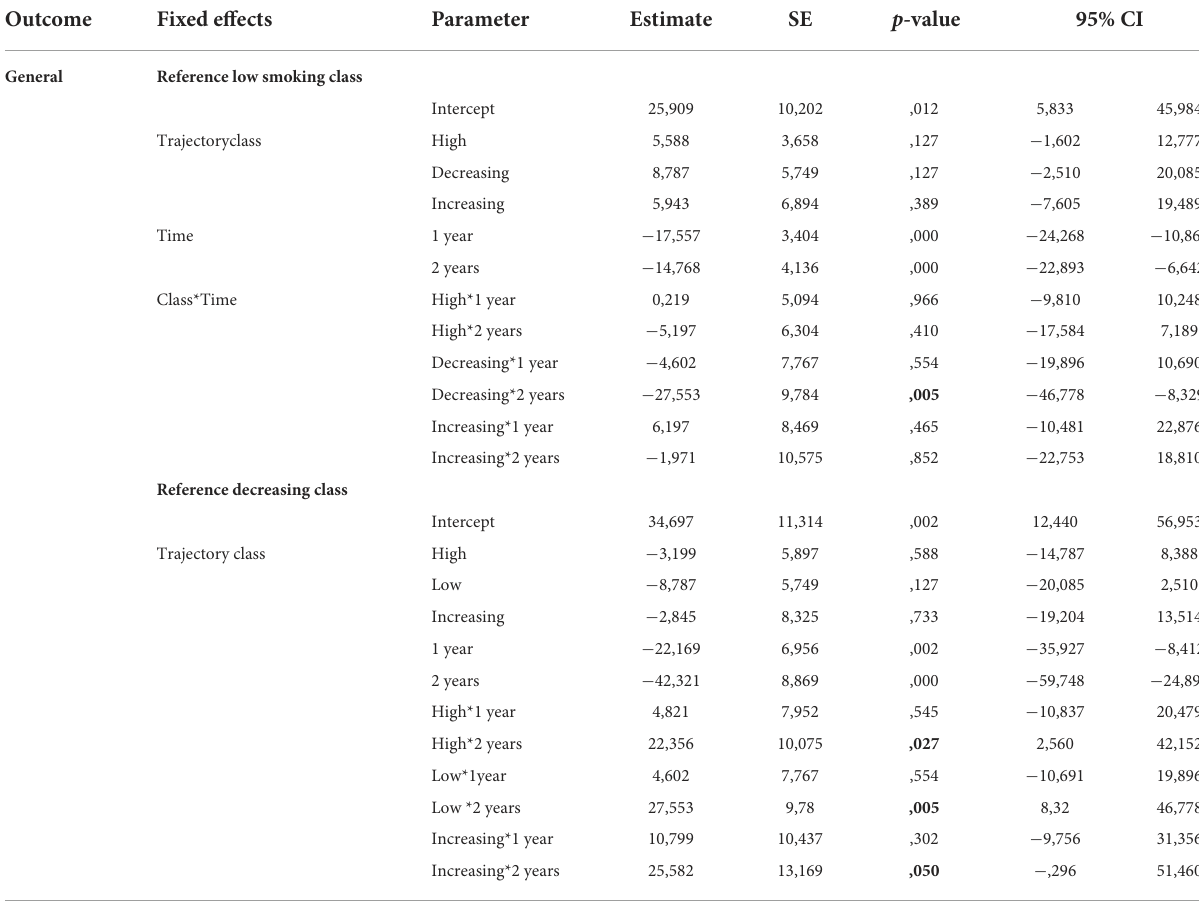
TABLE 5 Results of mixed model analyses of the effect of trajectory class membership on general symptoms.